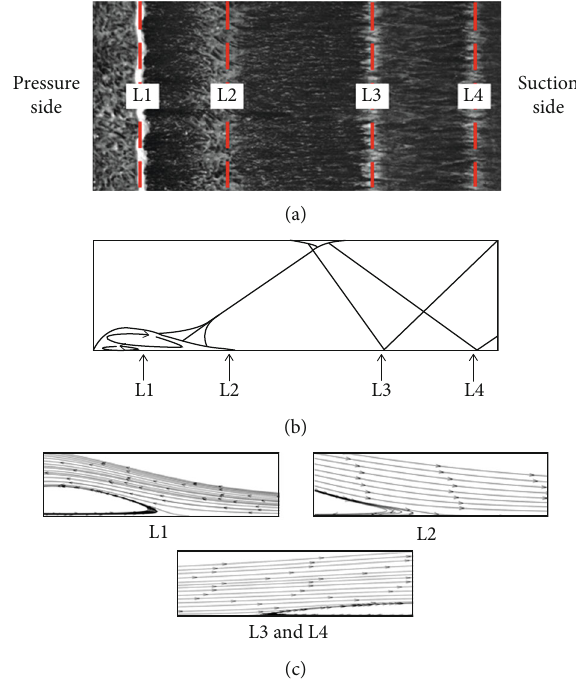
Figure 6: Oil fl ow stripes and schematic diagrams: (a) results of the oil fl ow visualization on the bottom wall; (b) schematic of the fl ow fi eld; (c) schematics of the streamlines near the